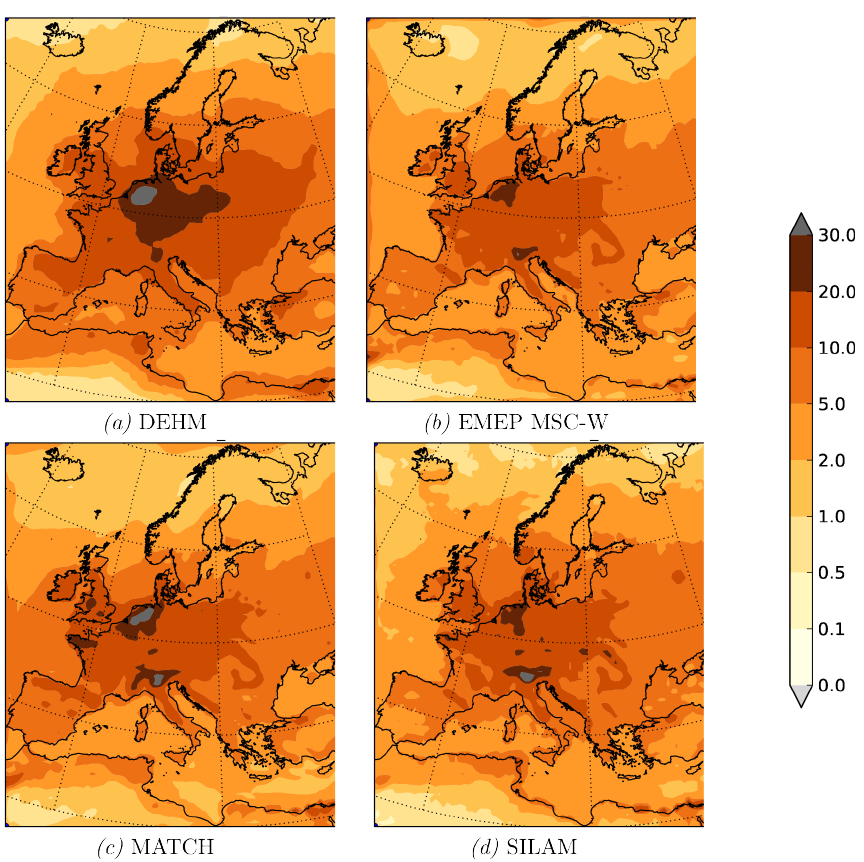
Figure 3. Calculated deposition of total Nr from the four CTMs. Results given as 20yr means (1990–2009) for the base case (E05-M00-BC1). Unit: kg ( N ) ha − 1 .